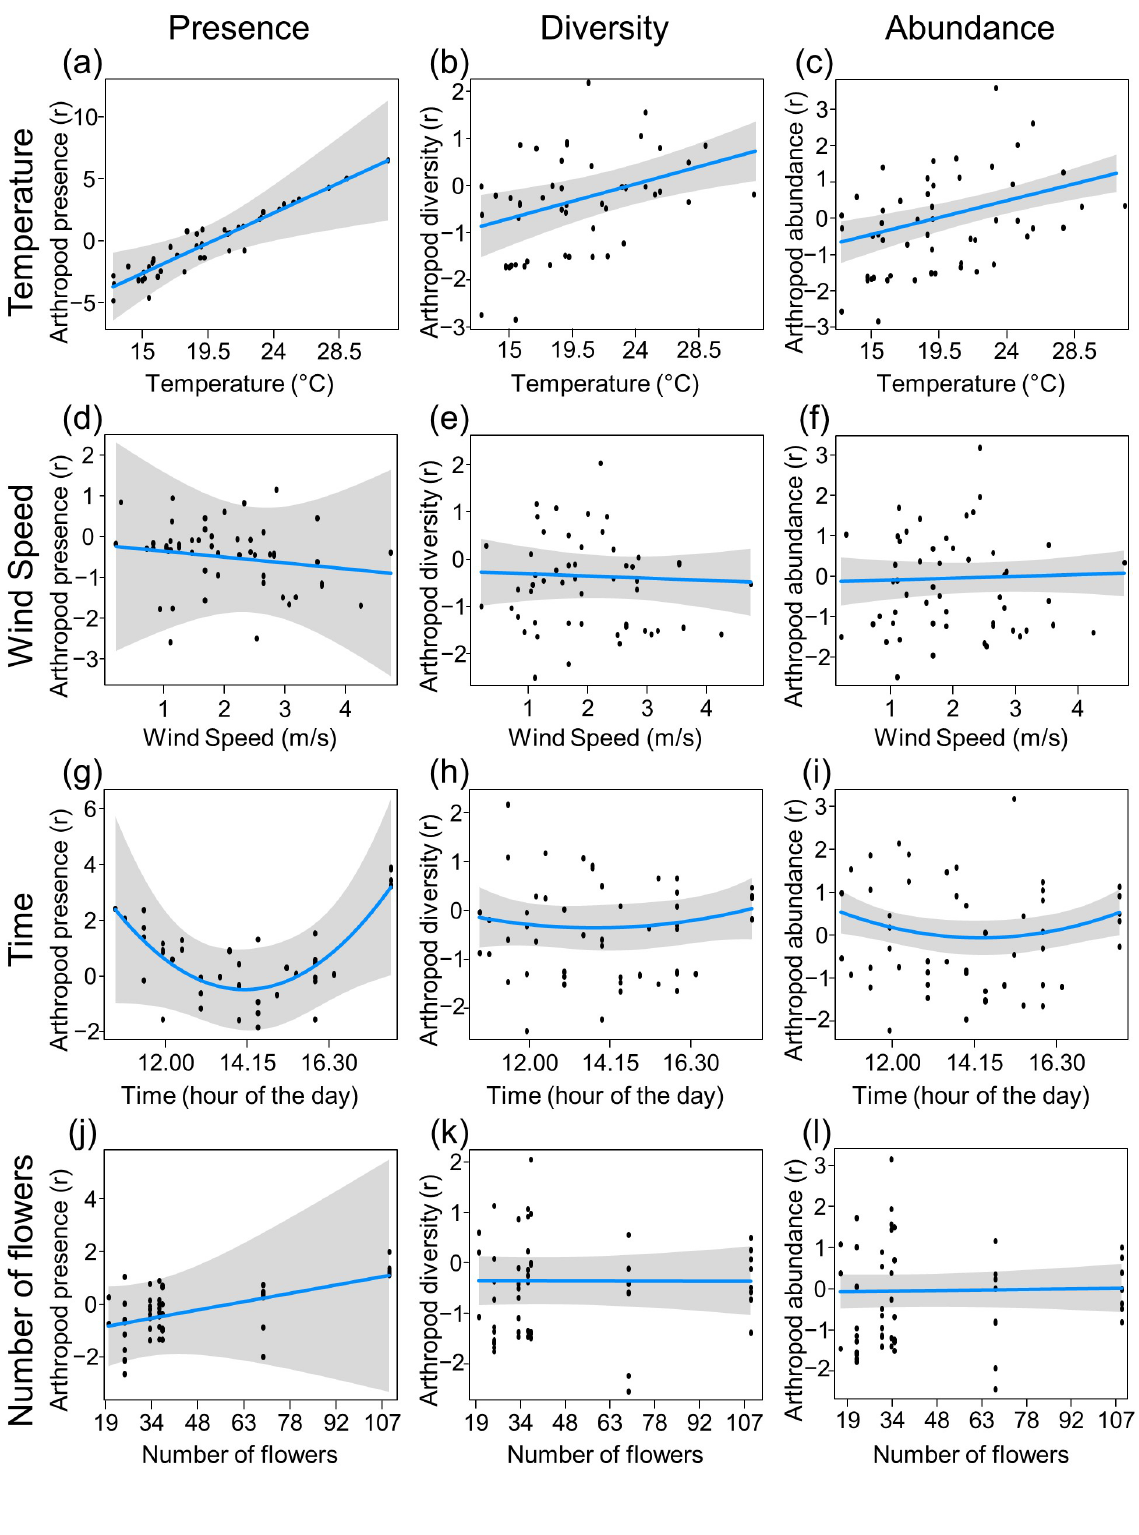
Figure 4. Partial residual plots showing the influence of temperature ( a – c ), wind speed ( d – f ), time (quadratic) ( g – i ), and number of flowers ( j – l ) on the presence ( a , d , g , j ), diversity ( b , e , h , k ) and abun- dance ( c , f , i , l ) of flower-visiting arthropods. Each black dot represents a sampling session. Blue lines indicate the mean value obtained using GLMs, while shaded areas represent 95% confidence bands; r =